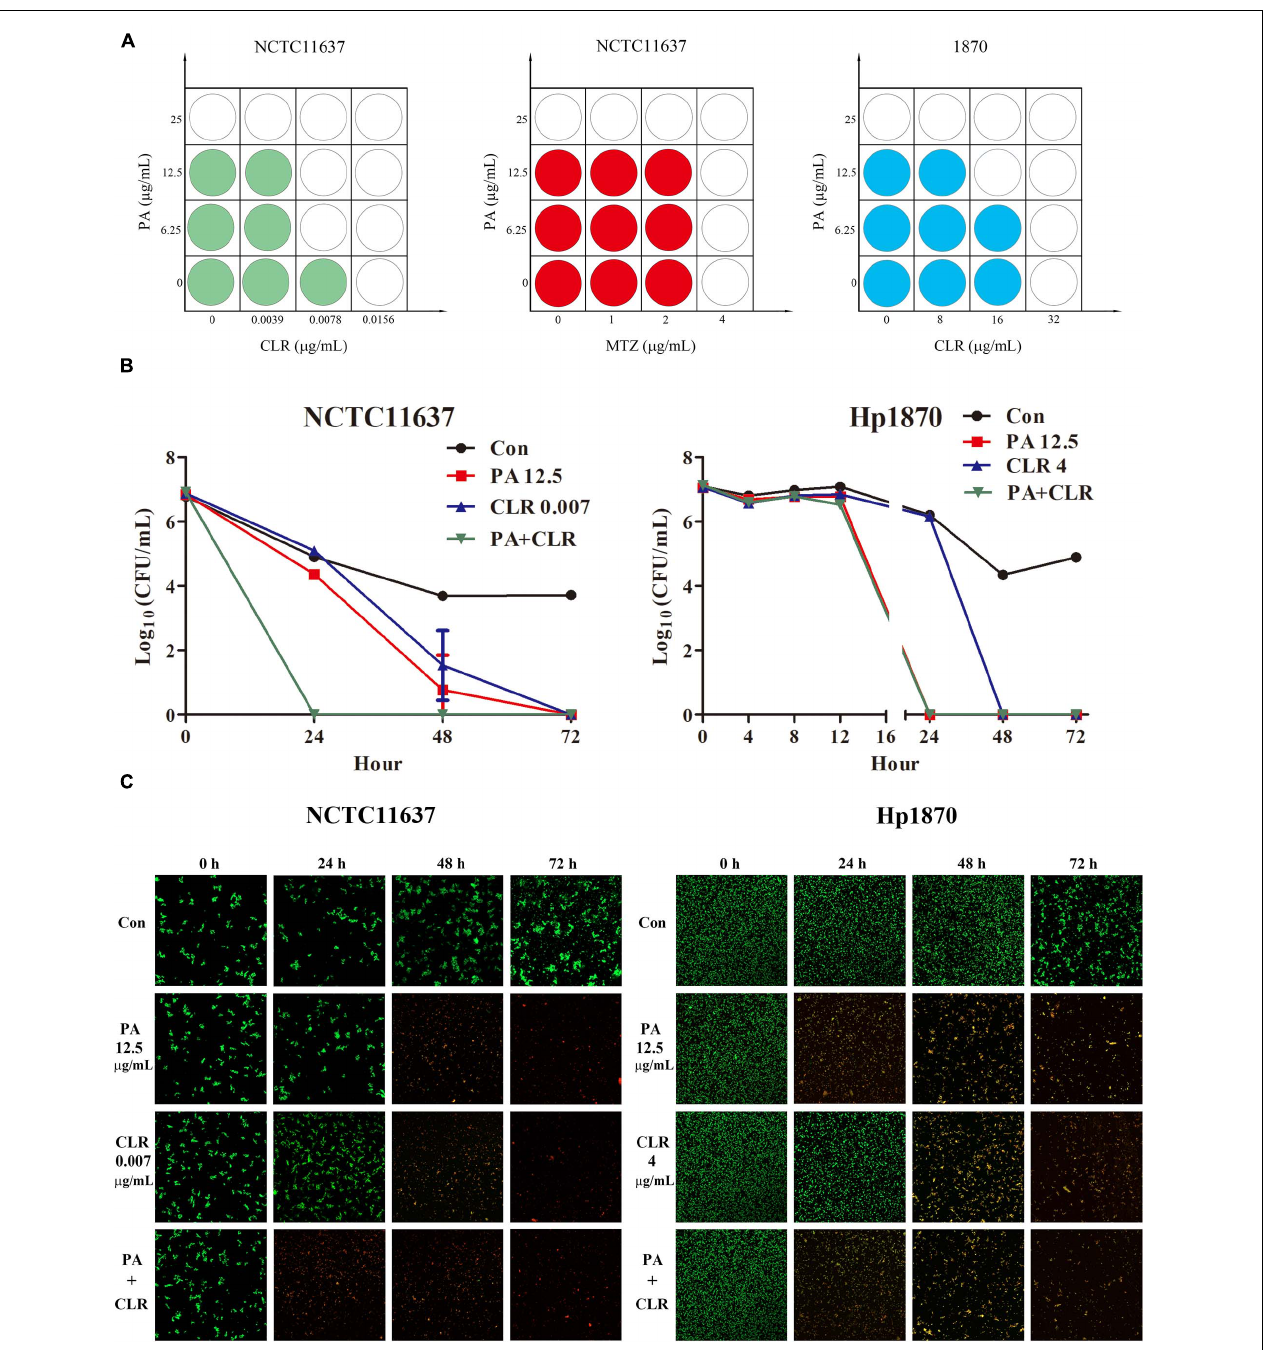
FIGURE 2 | Combined effect of PA and antibiotics against H. pylori . (A) Combined effect tested by the checkerboard method of PA and antibiotics against the H. pylori standard strain NCTC11637 and the drug-resistant strain Hp1870 as determined by FICI ( n = 4). (B) Combined effect tested by time–kill curves of PA and CLR against the H. pylori strains NCTC11637 and Hp1870; the synergy is defined as a ≥ 2-log 10 ( n = 3). (C) Bacteria imaging by Live/Dead BacLight Bacterial Viability kits to observe the bactericidal capacity of PA and CLR against H. pylori NCTC11637 and Hp1870.